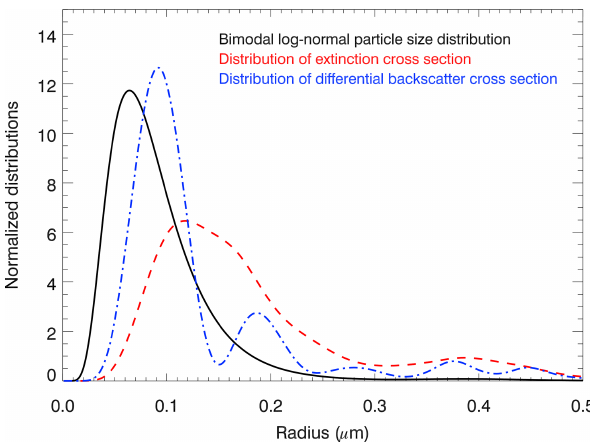
Figure 2. The black line shows the assumed bimodal particle size distribution with two log-normal modes and the following param- eters: r 1 = 80nm, S 1 = 1 . 6, r 2 = 400nm, S 2 = 1 . 15 and a coarse- mode fraction of χ = 10 − 2 . The red dashed line corresponds to the particle size distribution multiplied by the Mie extinction cross sec- tion σ ext (λ = 532nm ,r) . The blue dash-dotted line corresponds to the particle size distribution multiplied by the differential scattering cross section for a lidar backscatter geometry and also for a wave- length of 532nm. Note that all functions are